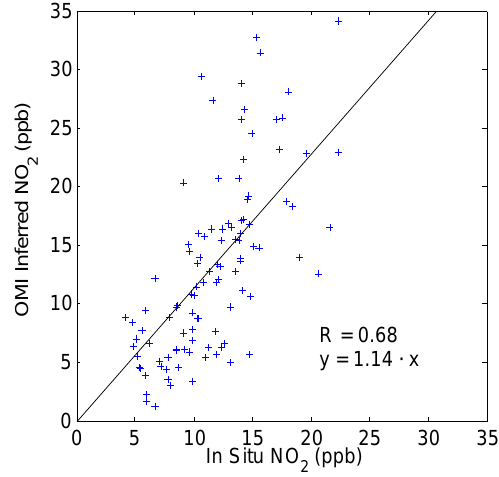
Fig. 10. Two-week average OMI inferred surface NO 2 vs. in situ CL NO 2 measurements for 2005–2009. Improvement in correlation ( R = 0 . 61 for DOMINO columns vs. in situ) was mainly due to a few periods in winter months, which showed greater agreement after the inference method was